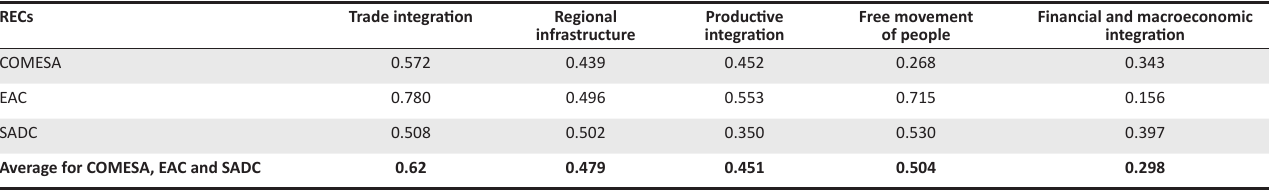
RECs Trade integration Regional